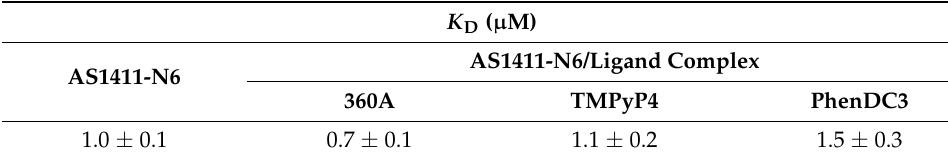
Table 4. K D constant values of AS1411-N6 and AS1411-N6/ligand complex upon titrated with NCL RBD